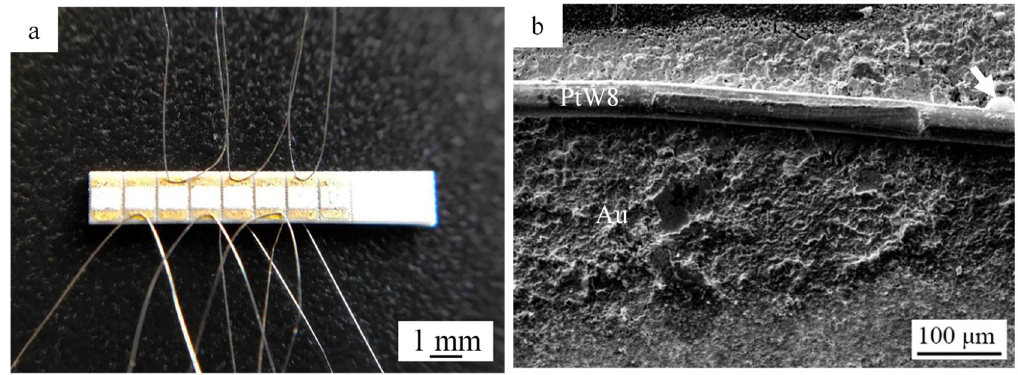
Figure 5. ( a ) Welded sample of a PtW8 wire and a Au thick film. ( b ) Surface morphology of a welded joint.